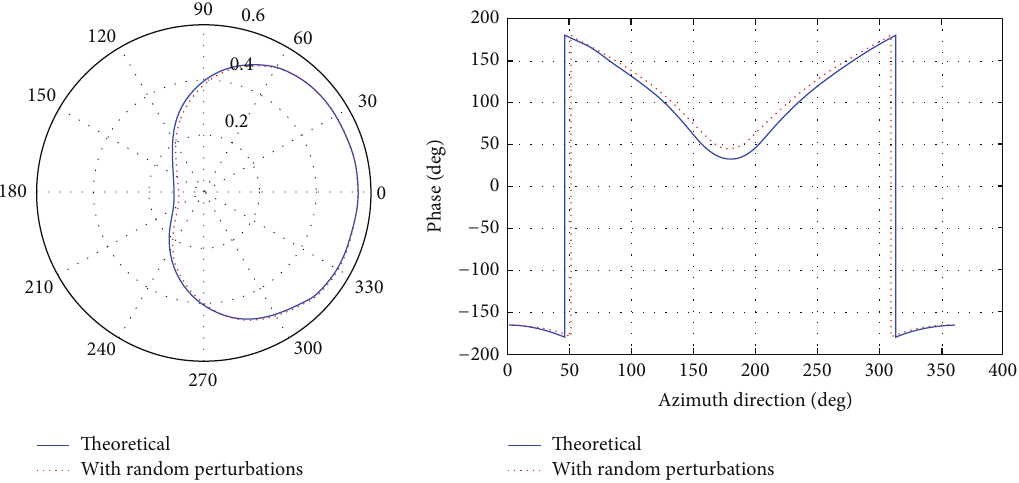
Figure 10: Theoretical and practical radiation patterns gains and phase.